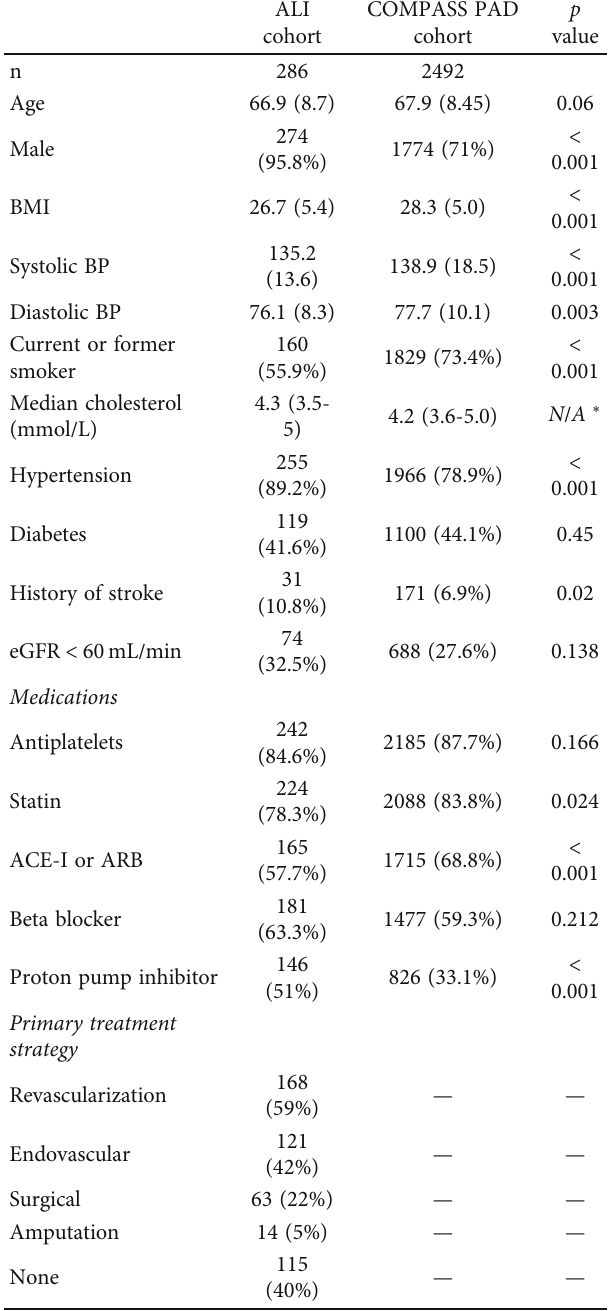
Table 1: Baseline covariates of veterans in the ALI cohort and patients with PAD in the COMPASS